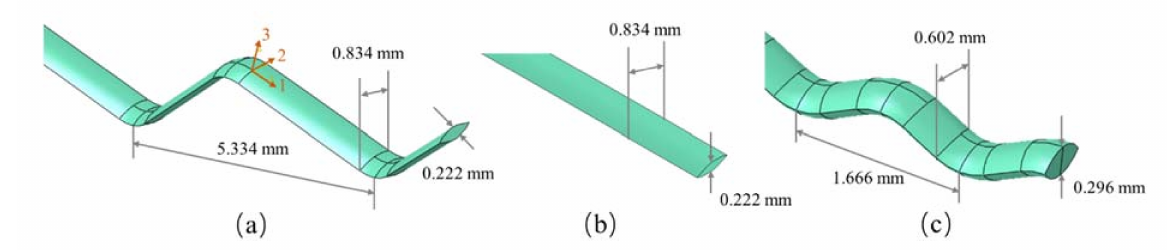
Figure 3. Geometrical parameters of yarns: ( a ) the Z-warp of 5-AI; ( b ) the weft yarn of 5-AI; ( c ) the warp and weft of plain weave fabrics.